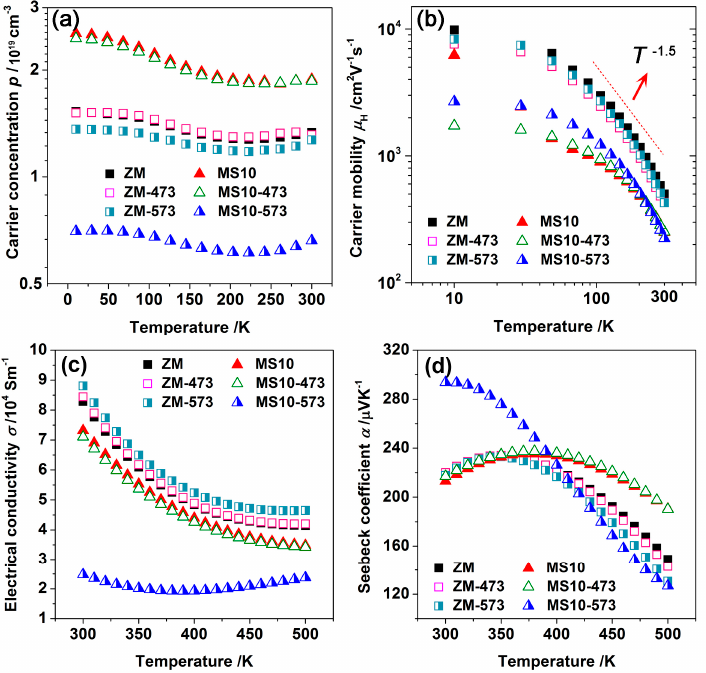
Figure 3. Temperature dependence of ( a ) carrier concentration; ( b ) carrier mobility; and ( c ) electrical conductivity; ( d ) Seebeck coefficient for ZM and MS10 samples before and after annealing.